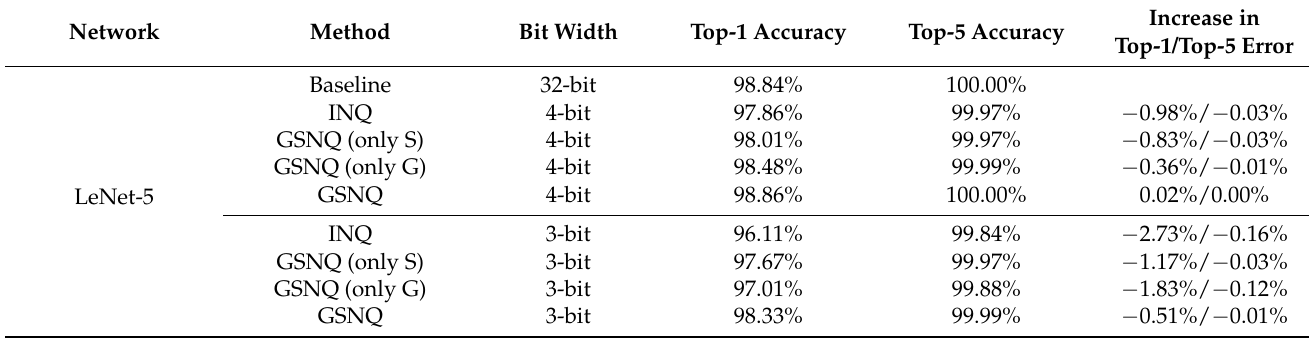
Table 4. Ablation experiments on LeNet-5 on the MNIST dataset.